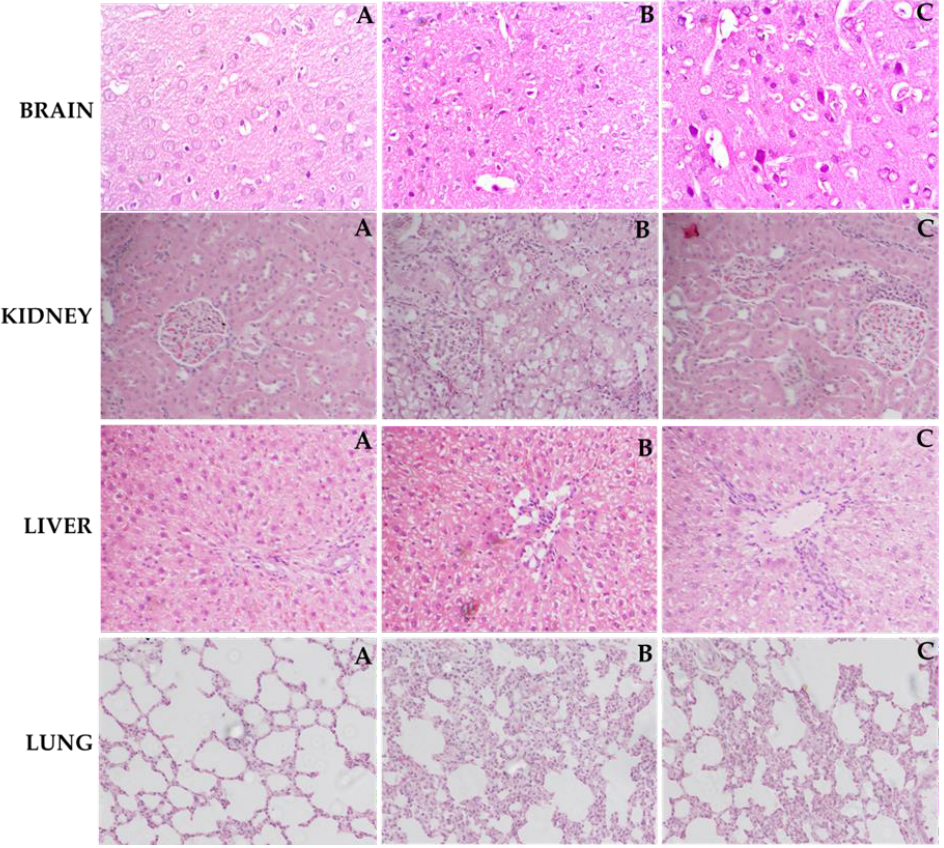
Figure 8. Light histograms of different rat organs (hematoxylin and eosin stains, magnification 40× and scale bar of 100 µm). Effect of ZIN in LPS intoxicated rats. Brain ( A ) normal control group: Showing normal histological structure with intact neurons. ( B ) LPS treated rats: Showing neuronal loss with condensed nuclei. ( C ) Rats treated with (ZIN 150 mg/kg + LPS: Showing decrease in neuronal loss with presence of intact neurons. Kidney ( A ) normal control group: Showing normal histological structure of the glomeruli and tubules at the cortex with absence of histopathological alterations. ( B ) LPS treated rats: Showing marked inflammatory cell aggregation in between the tubules, marked degeneration in the lining epithelium of all the tubules, and blood vessel congestion. ( C ) Rats treated with (ZIN 150 mg/kg + LPS: Showing absence of histopathological alterations. Liver ( A ) Normal control group: Showing normal histological structure of the central vein and intact hepatocytes. ( B ) LPS treated rats: Showing severe loss of hepatic architecture with multiple focal necrosis, ballooning degeneration in the hepatocytes. ( C ) Rats treated with ZIN 150 mg/kg + LPS: Showing absence of histopathological alterations. Lung ( A ) Normal control group showing normal morphology ( B ) LPS treated rats: Showing moderate to severe hemorrhage, thickening of alveolar septa, emphysema, and infiltration of leukocytes in walls alveoli, ( C ) Rats treated with ZIN 150 mg / kg + LPS: Showing absence of histopathological